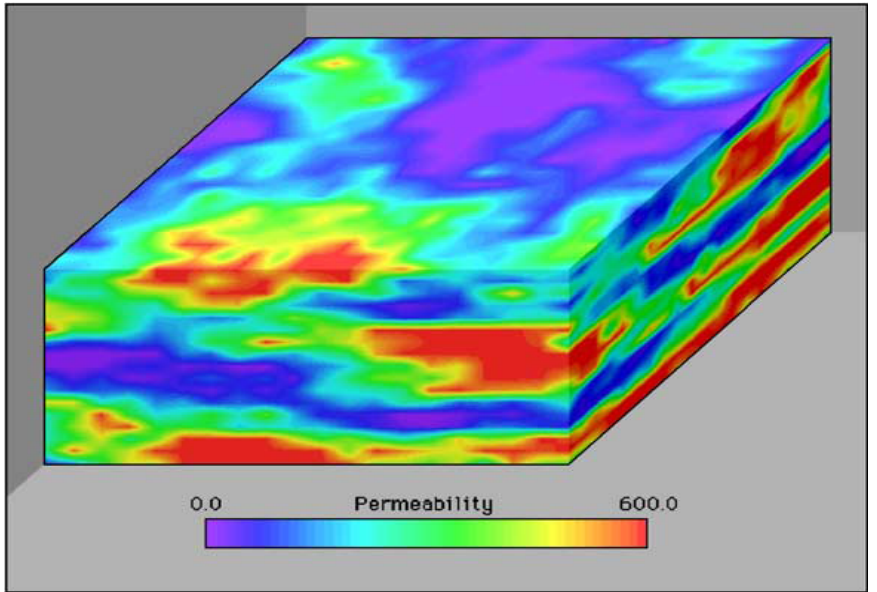
Figure 2. Permeability map of the sector